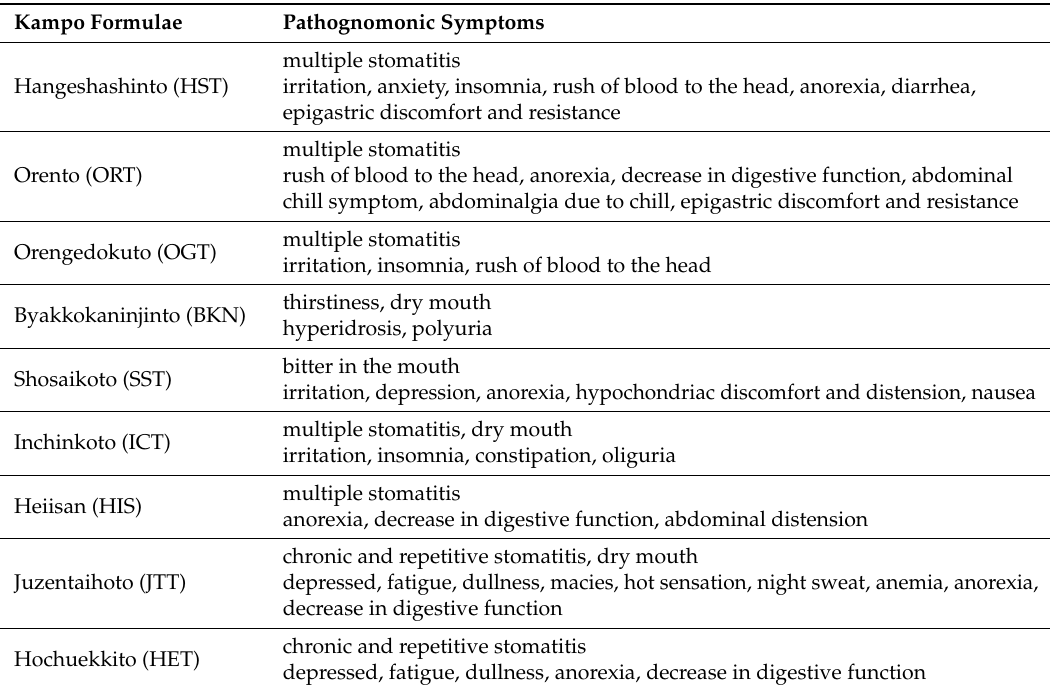
Table 2. The effectiveness of each Kampo formula according to the pathognomonic symptoms of